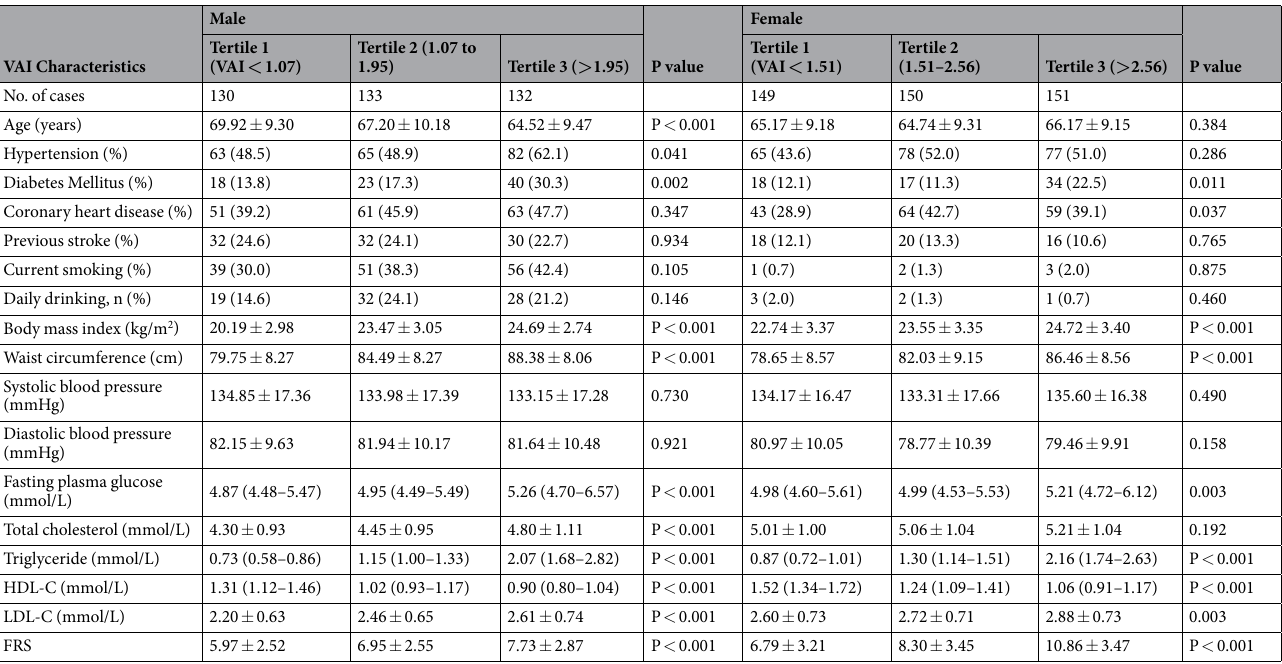
Table 1. Characteristics of patients stratified by VAI tertiles. Continuous variables were analysed with one-way analysis of variance or the Kruskal-Wallis test, and categorical variables were analysed with the chi-square test or Fisher’s exact test. Results are expressed as mean ± SD for variables with a normal distribution, as median and interquartile range for variables with a skewed distribution, or as number with percentage for categorical variables. SD, standard deviation; HDL-C, high density lipoprotein cholesterol; LDL-C, low density